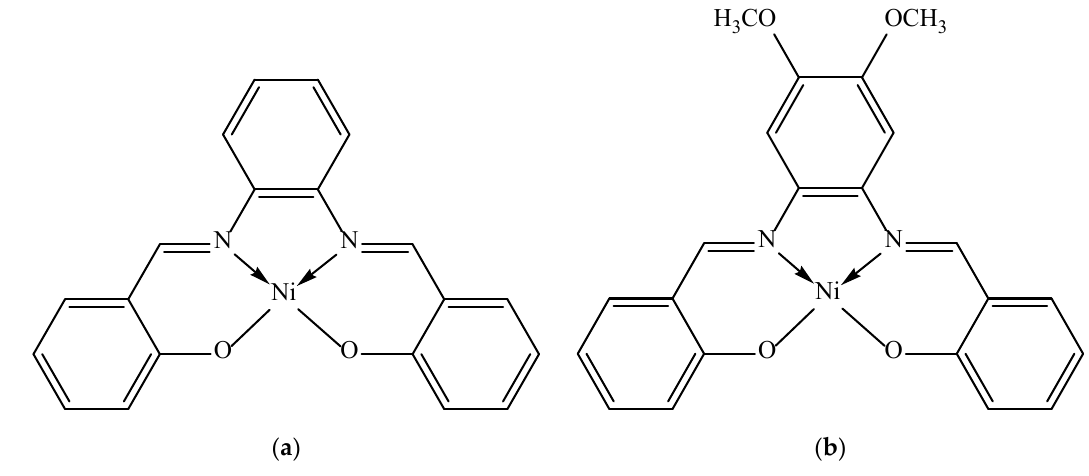
Figure 1. Molecular structures of [NiSalphen] ( a ) and [NiSalphen(CH 3 O) 2 ] ( b ).